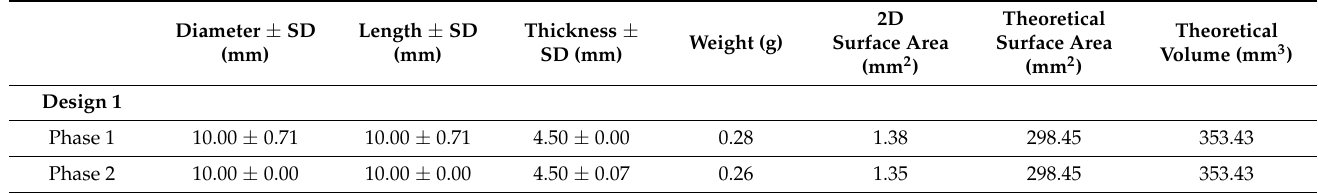
Table 5. Different infill densities of 3D ‐ printed gummy bear shape tablets (design 4). Data for diam ‐ eter, length, and thickness represent the mean ± standard deviation (SD), where n = 2.